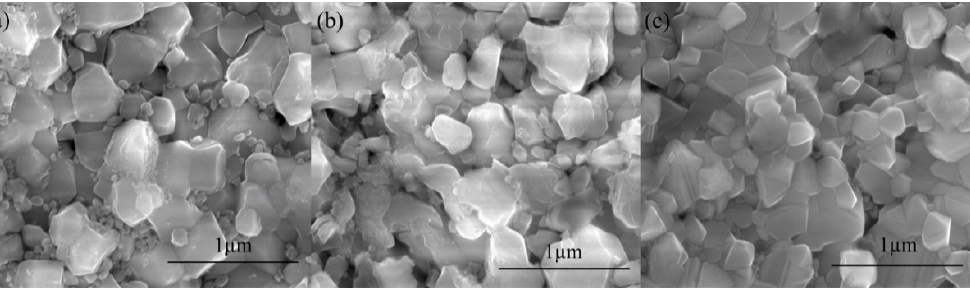
Figure 3. SEM images of the cross-section view of ( a ) 10-GDC, ( b ) 15-GDC, and ( c ) 20-GDC ceramic pellets at 100 k magnification.